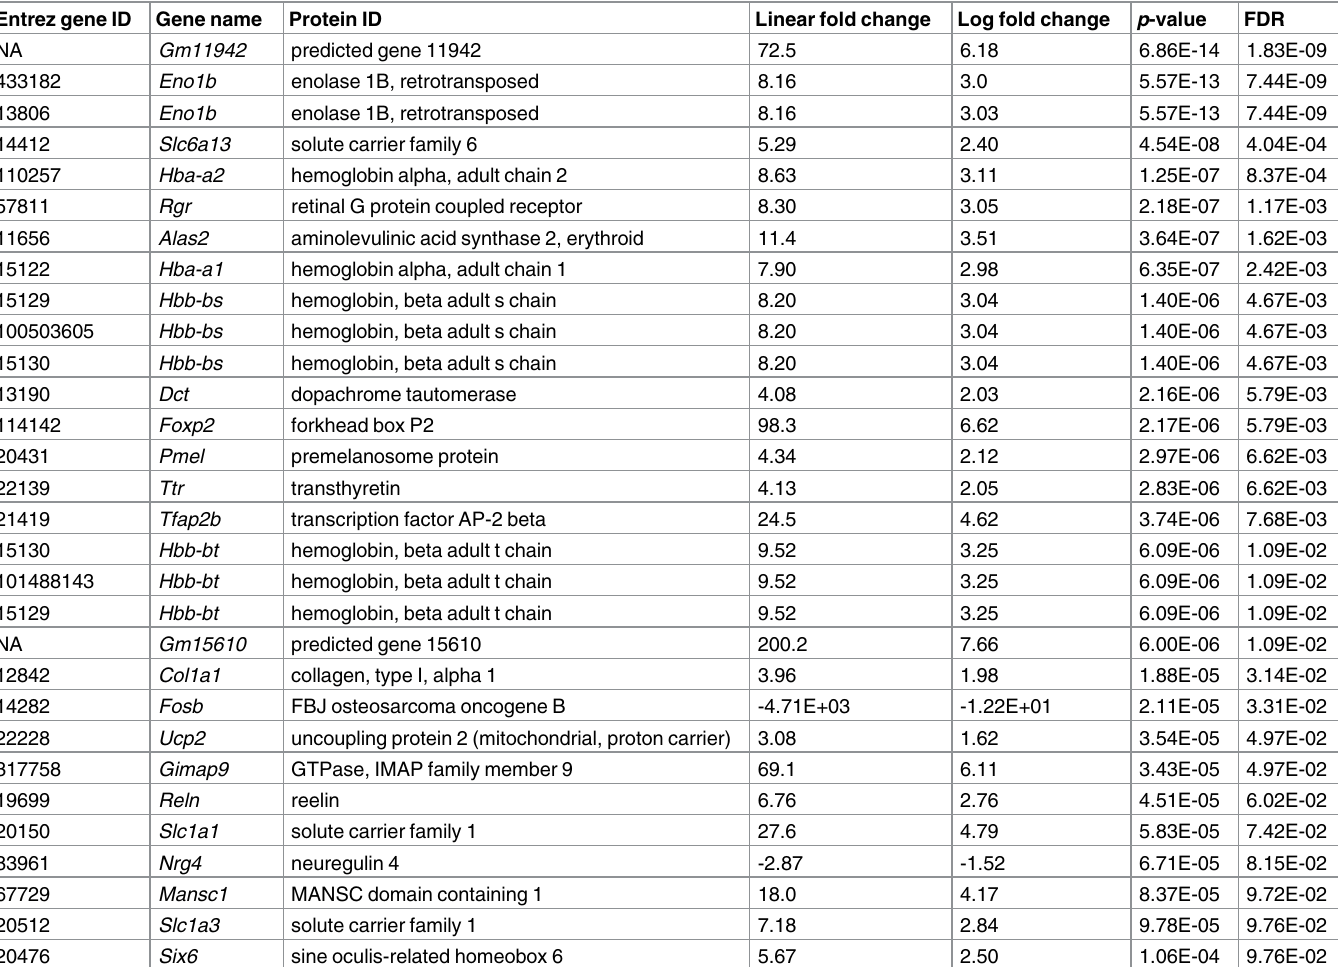
Table 3. List of top 30 genes with altered abundance in Cryab -R120G-het mouse lenses. Entrez gene ID Gene